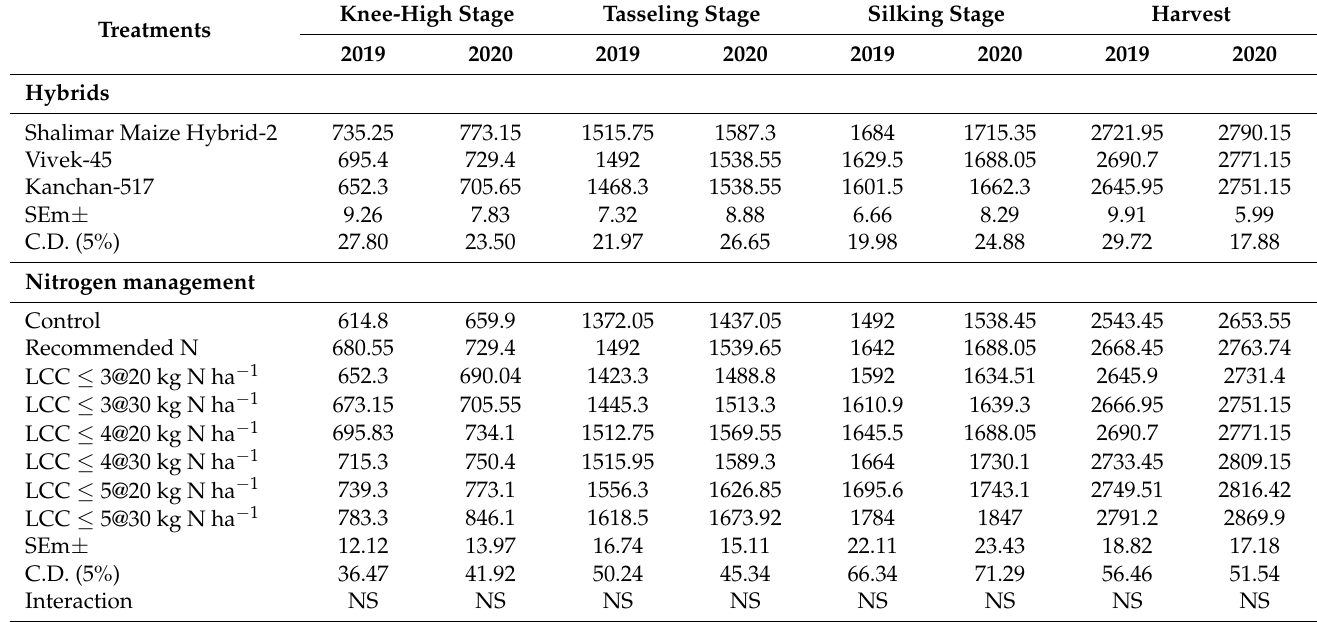
Table 4. Effect of precision nitrogen management through LCC on GDD ( ◦ C) of different hybrid maize